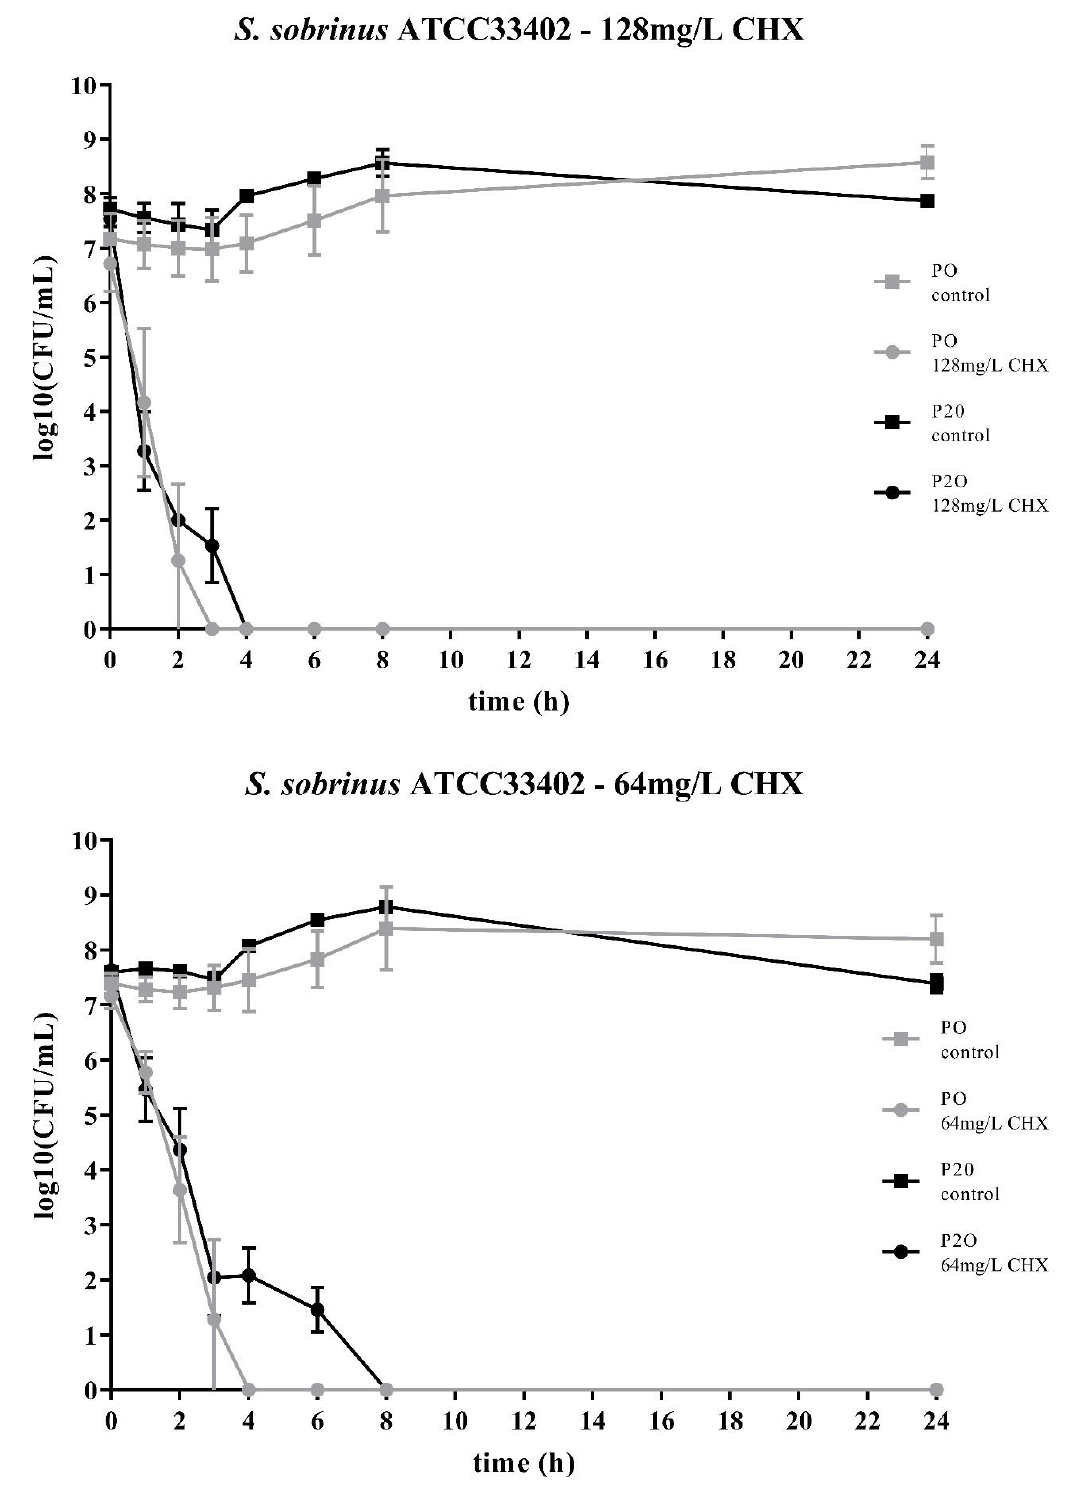
Figure 2. Time-kill curves of S. sobrinus ATCC33402 exposed to different concentrations of CHX. “P0” indicates the bacterial isolate that had not been passaged before on CHX, while “P20” denotes the isolate that have been subcultivated for 20 passages in subinhibitory concentrations of CHX, respectively. The streptococcal isolates were exposed to either 64mg/L or 128mg/L CHX. The values, shown as log10(CFU/mL), are means of three independent replicates. Error bars indicate the respective standard deviation. As control, untreated cultures without CHX were tested.